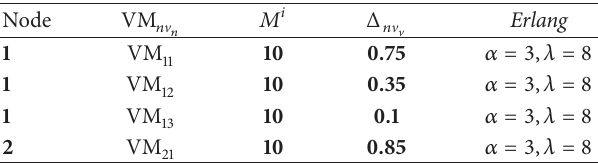
Table 2: Without communications. High optimal Erlang . VM con- figurations.